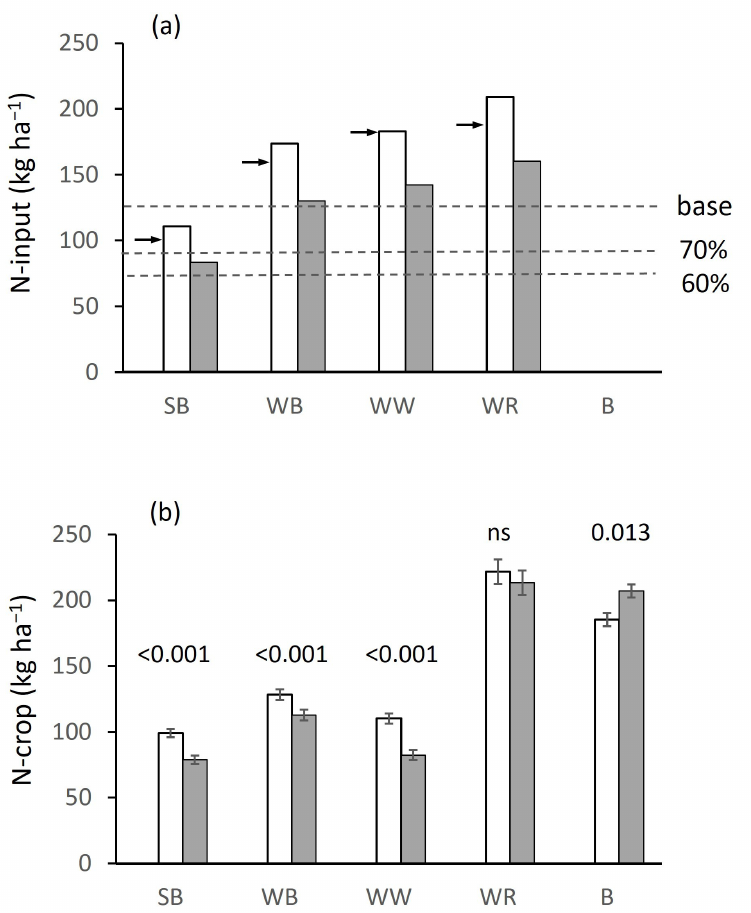
Figure 4. Comparison of standard (unshaded) and integrated (shaded) treatments at the platform for SB, spring barley; WB, winter barley; WW, winter wheat; WR, winter oilseed rape; and B, spring bean: ( a ) mineral nitrogen input, arrow indicating mean from regional fertiliser survey, beans not receiving nitrogen, dashed lines indicating regional N-input at 1990 base and reduction targets of 70% and 60%; and ( b ) nitrogen in the plant before harvest, plus and minus SE, p values showing significance of difference between